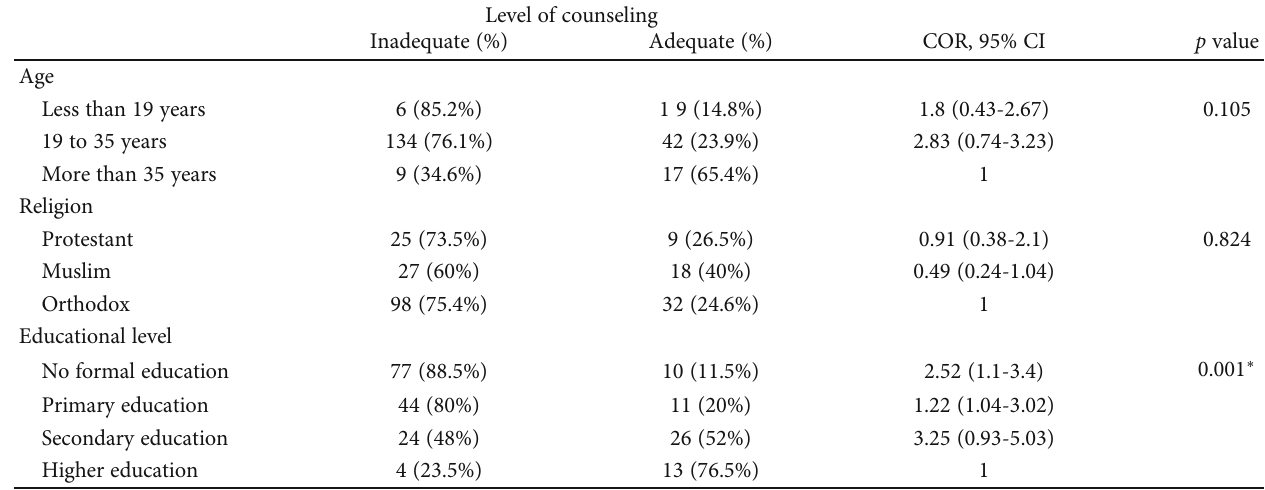
Table 3: Level of family planning counseling, Addis Ababa, Ethiopia